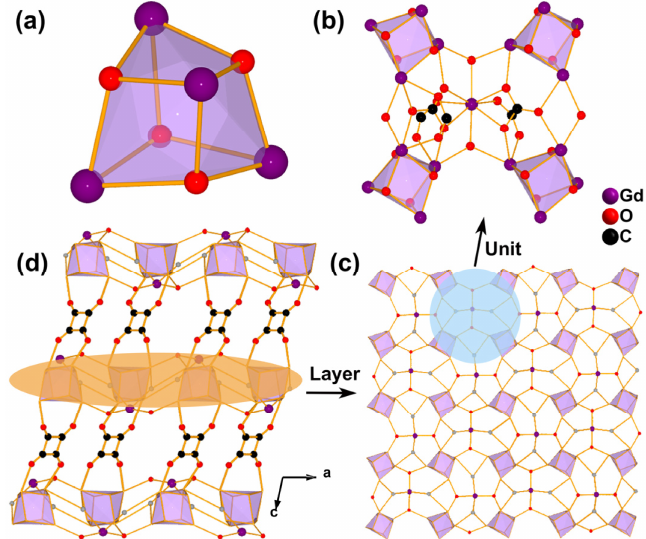
Figure 1. ( a ) [Gd 4 (OH) 4 ] n8n+ cubane; ( b ) Butterfly-shaped unit of [Gd 17 (OH) 20 (HCOO) 3 (CO 3 ) 2 ] n24n+ in 1 ; ( c ) topology of the layer structure of [Gd 5 (OH) 6 (HCOO) 3 (CO 3 ) 2 ] n2n+ constructed by the butterfly-shaped units through sharing edges; ( d ) the 3D structure of 1 formed through the adjacent layer structures pillared by C 4 O 4 2 − in a µ 4 − η 1 : η 1 : η 1 : η 1 coordination mode. Hydrogen atoms are omitted for